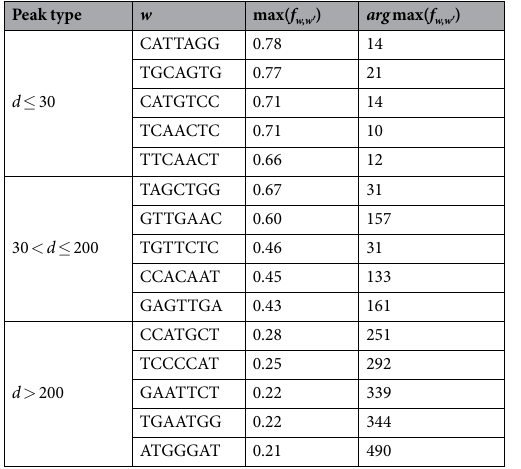
Table 2. Words with highest f w , w ′ maximum, with indication of maximising distance, for word length 7, organised by peak type: d ≤ 30, 30 < d ≤ 200 and d > 200.